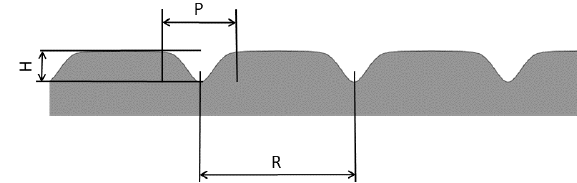
Fig. 4. Microstructure – sketch.